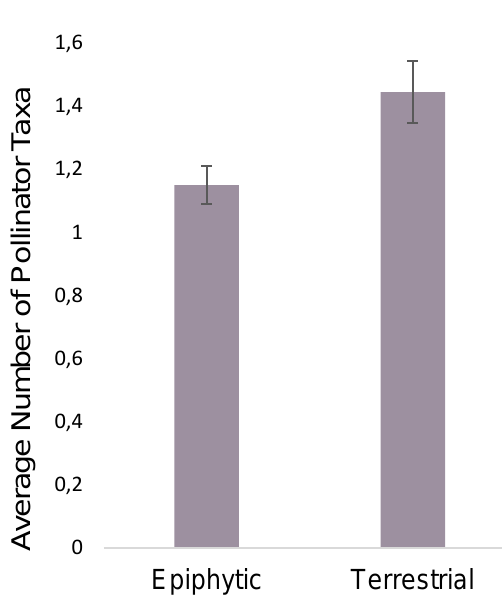
Figure 5. The average number of pollinator taxa (to the Order level) documented to pollinate epiphytic and terrestrial orchids. The terrestrial orchid genera were pollinated by significantly more taxa (1.45 ± 0.1) than the epiphytic genera (1.15±0.06) ( P = 0.011) Error bars represent the standard error of the mean.